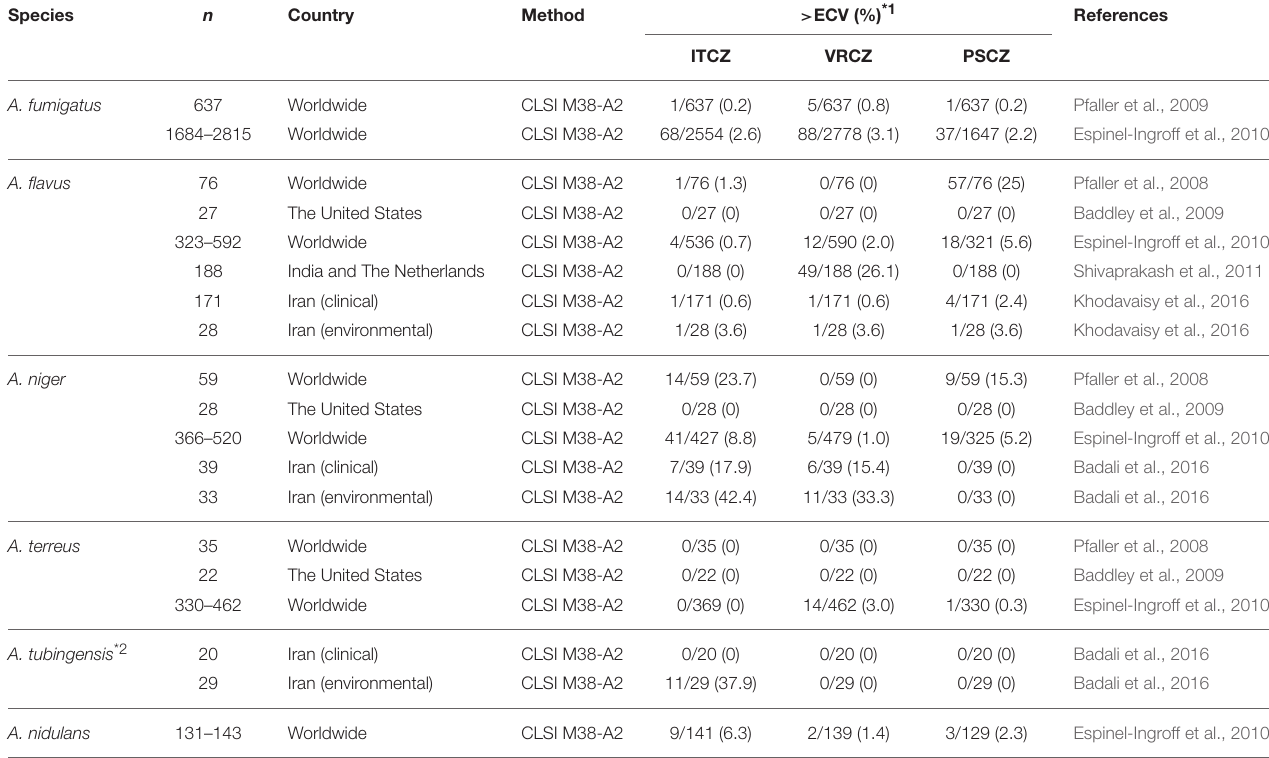
TABLE 2 | Summary of the rates of azole resistance amongst Aspergillus species. Species n Country Method > ECV (%)